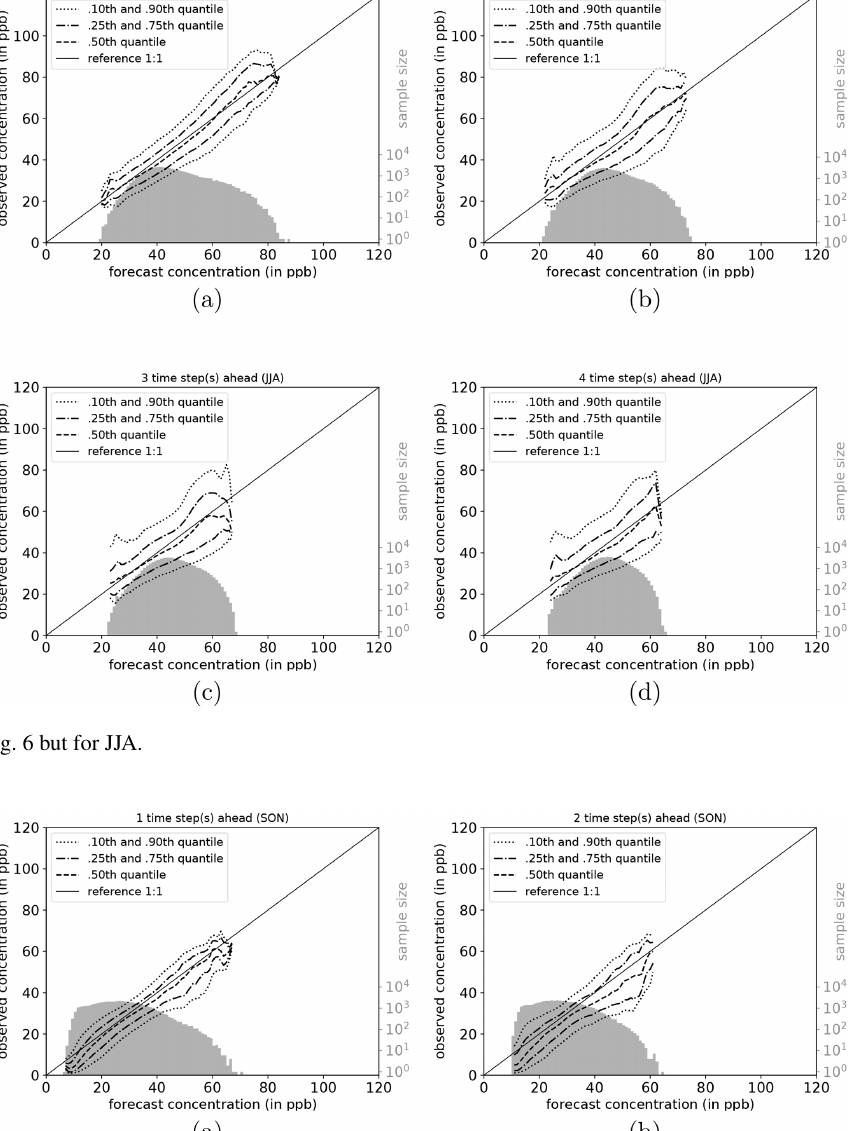
Figure A6. Same as Fig. 6 but for JJA.